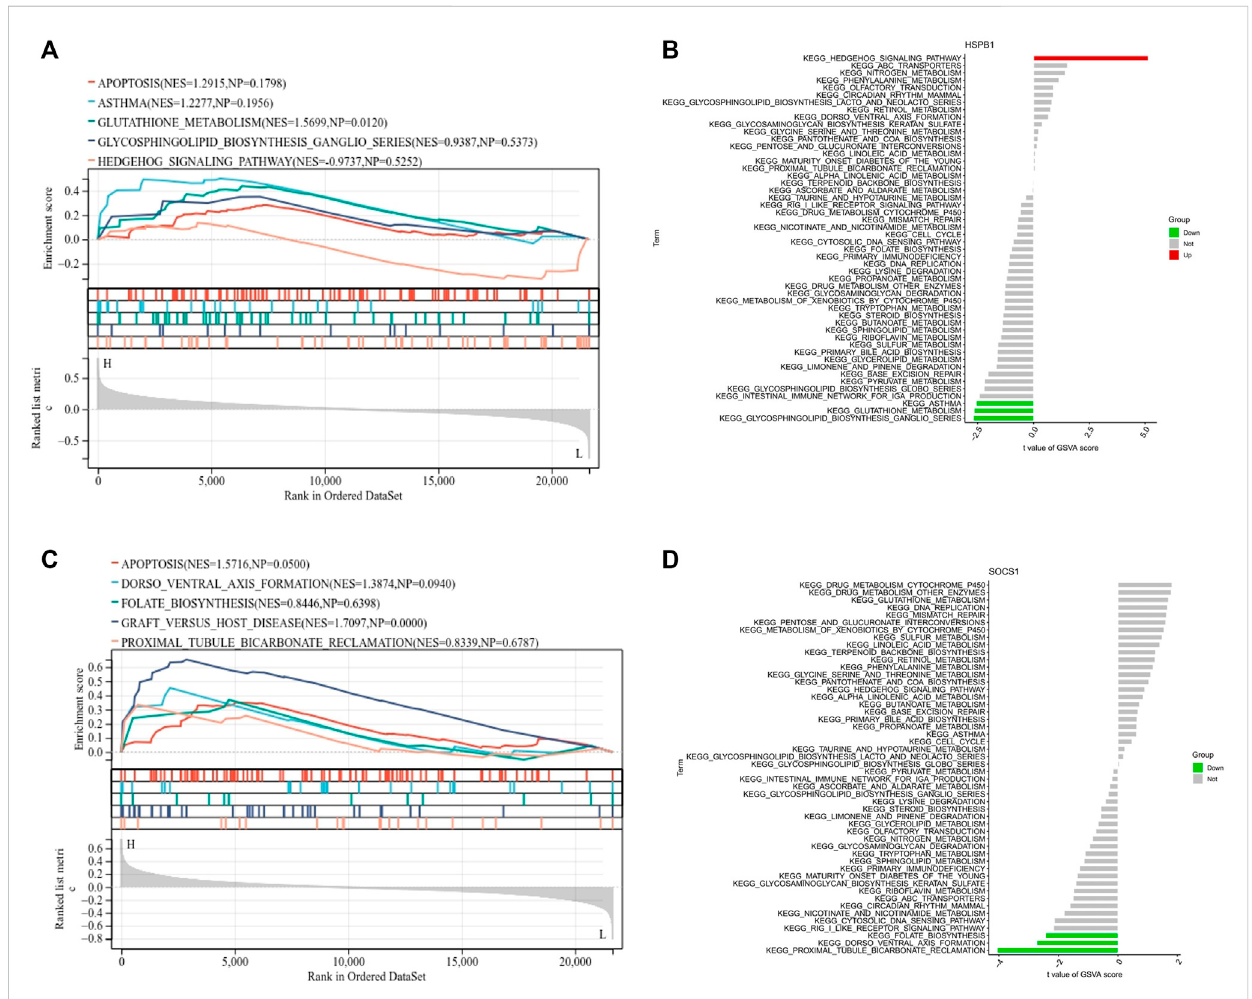
FIGURE 6 Single gene GSEA and GSVA analysis. (A,B) GSEA and GSVA analysis of HSPB1. (C,D) GSEA and GSVA analysis of SOCS1.